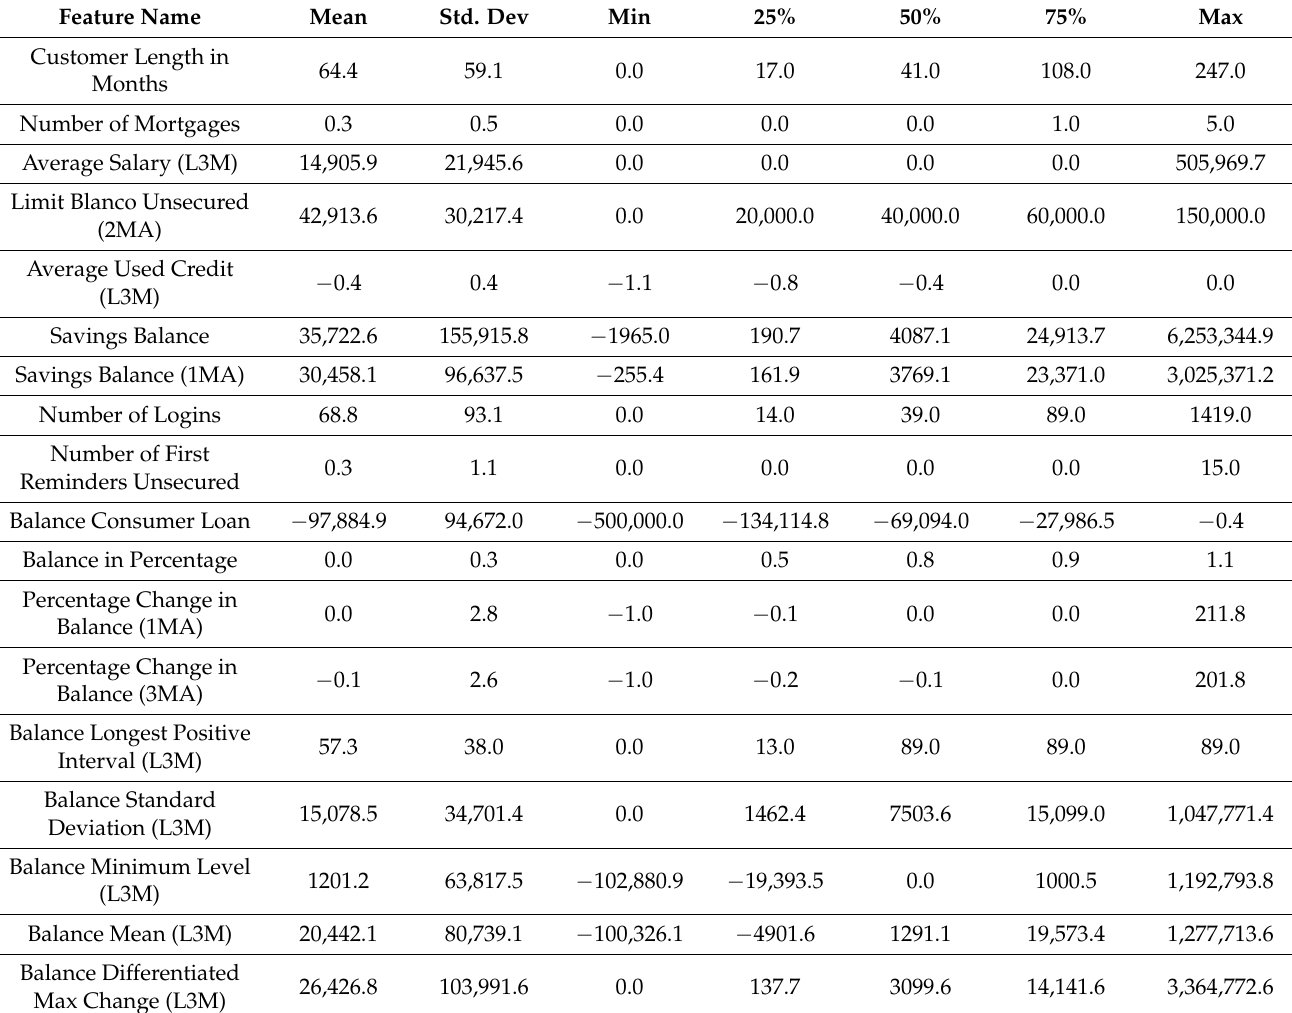
Table 1. Feature statistics for the training set consisting of 8381 instances (60% of the data). Note that the data is not